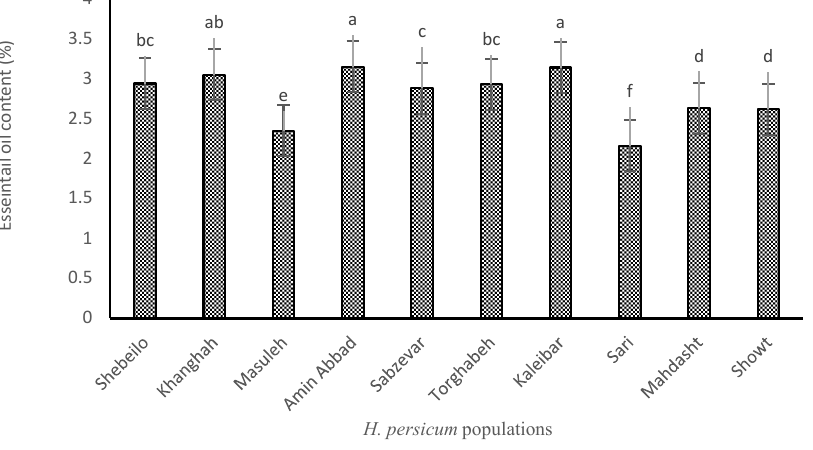
Figure 1. EO content of different H. persicum populations. Means ± standard deviations with same letters do not have significant difference from each other.